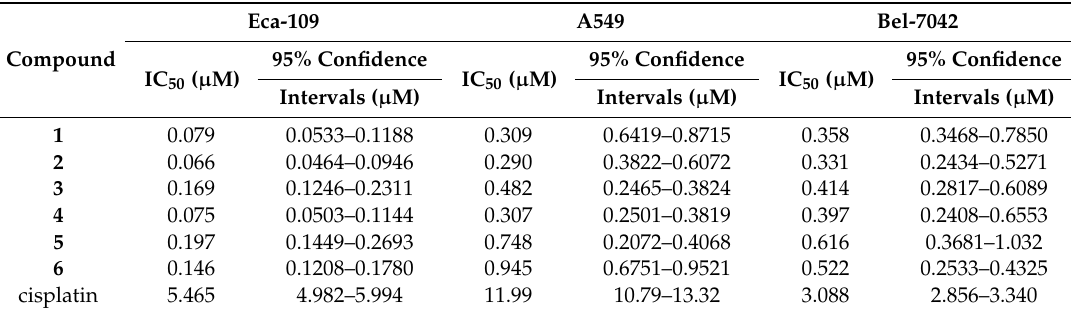
Table 1. IC 50 of complexes against human cancer cells in